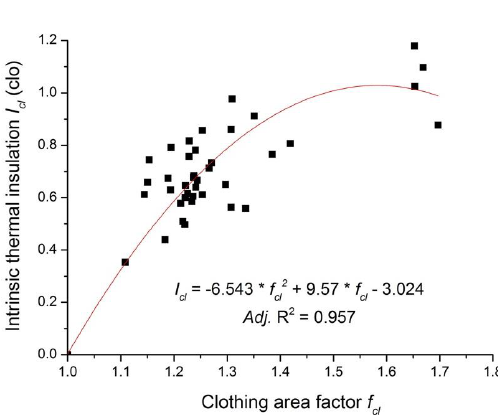
Figure 4. Parabolic correlation of the clothing area factor with the intrinsic thermal insulation.